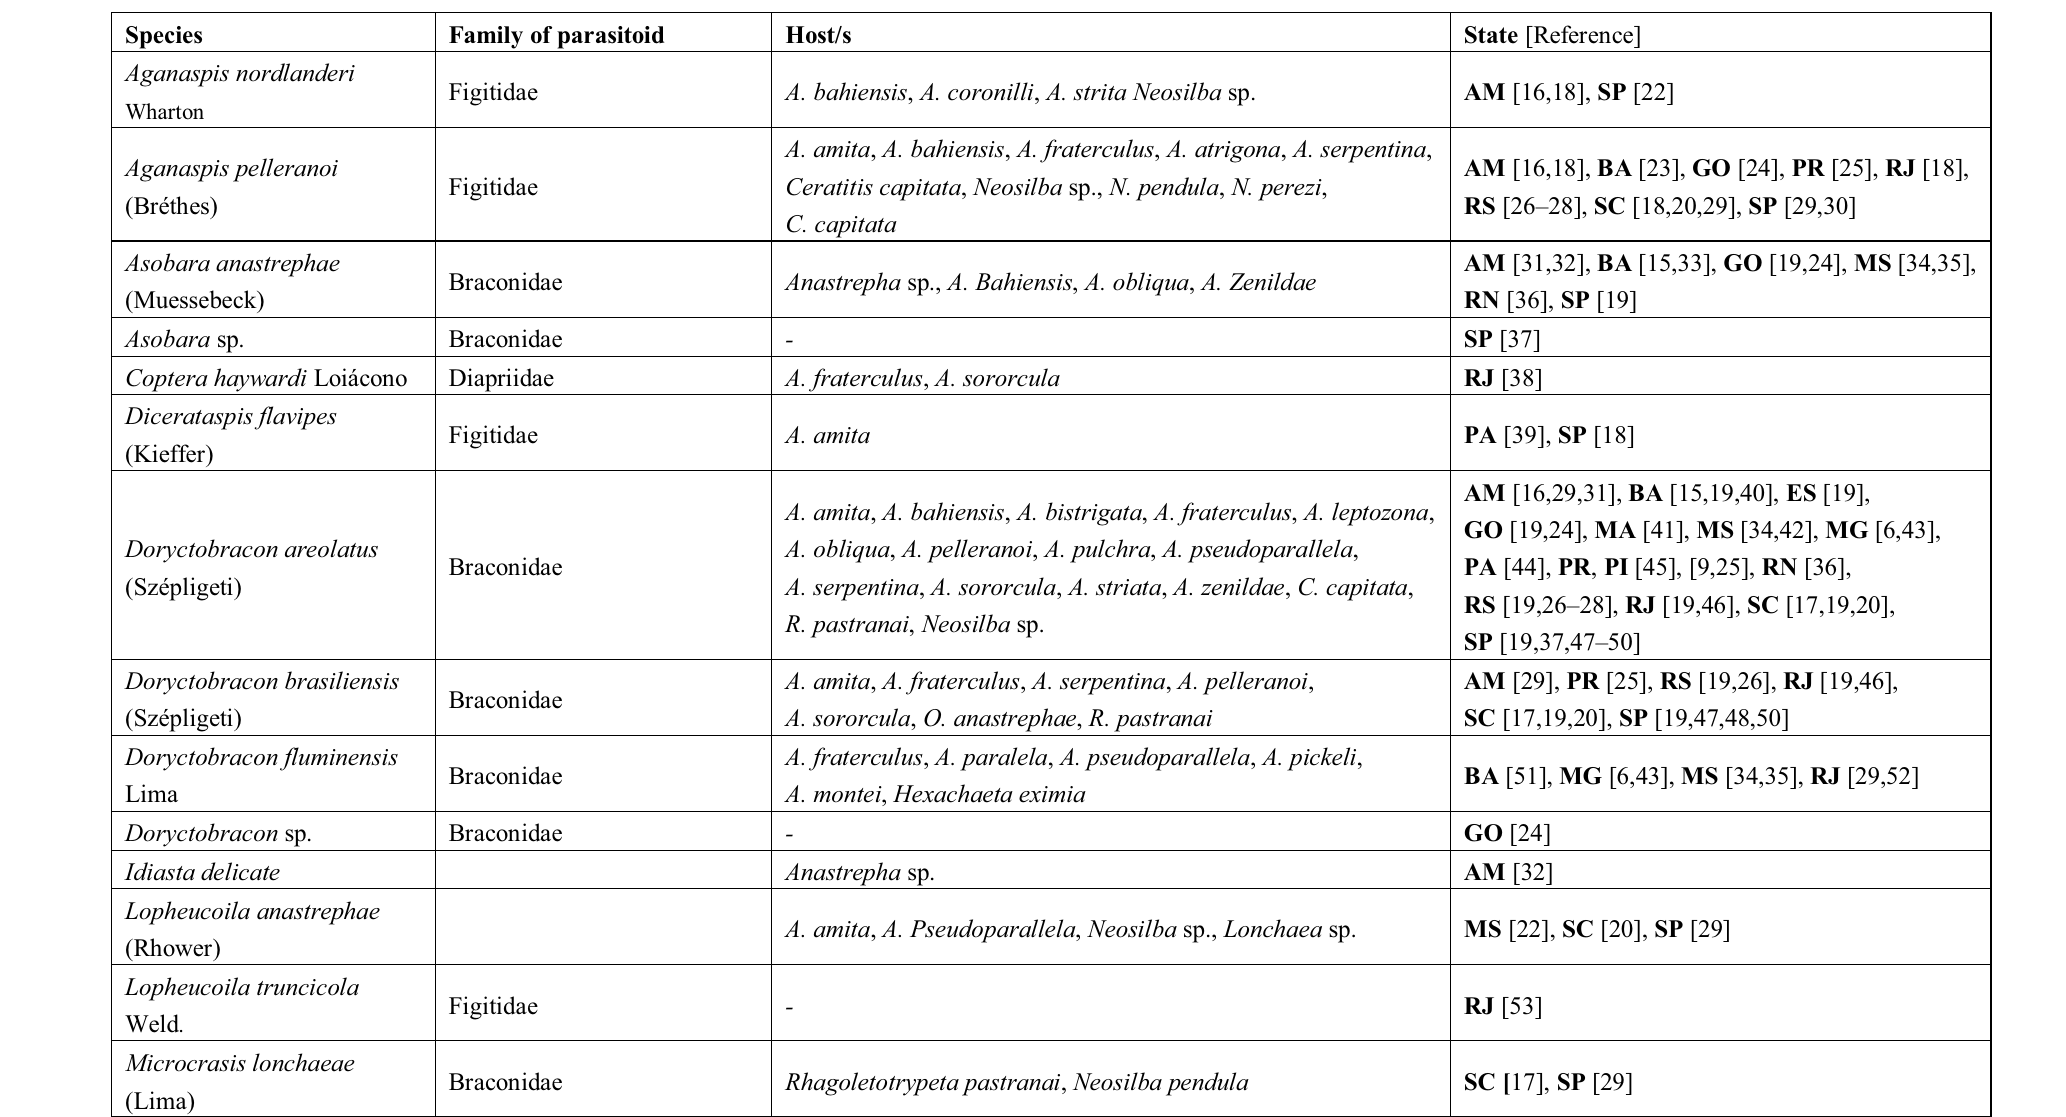
Table 1. List of parasitoids and their fruit fly hosts in